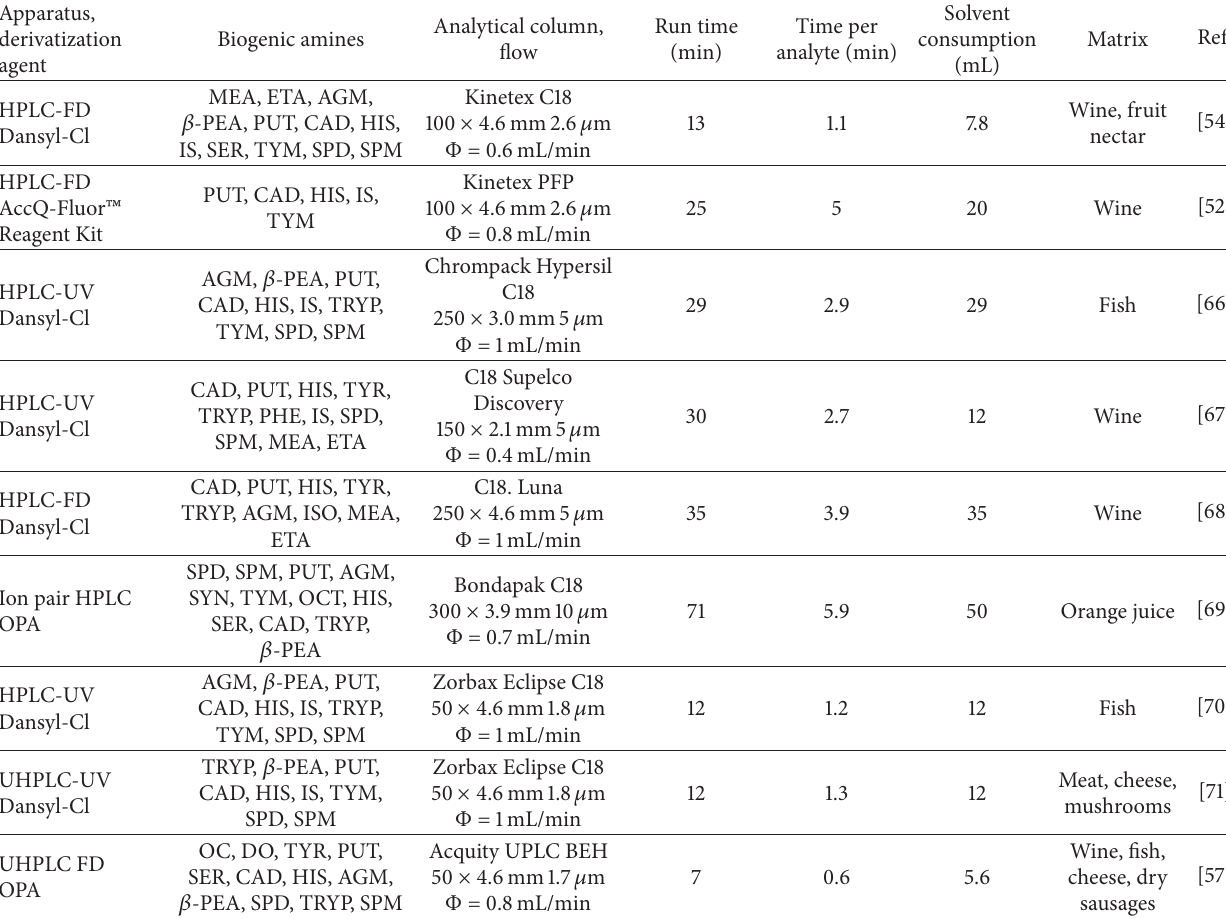
Table 1: Literature comparison to the proposed method for the determination of biogenic amines (adapted from [54]).